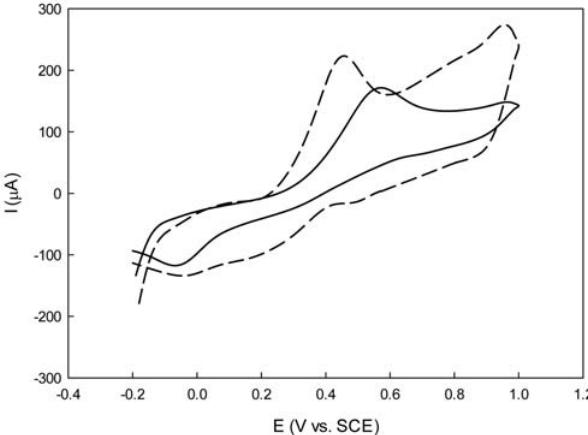
Fig. 8. CVs for electro-chemical oxidation of HQ (2.0 mM) in a phosphate buffer solution (pH 5.0) at Pt/PAAQ-SDS modified elec- trode (dash-dash) and bare Pt electrode